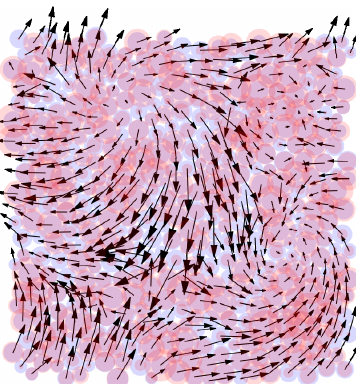
FIG. 6. Example of soft mode with ω ≈ 0 . 078 for ¯ α ¼ 1 and Δ ¼ 10 − 2 . Blue disks indicate the initial particles radii, red disks the new radii induced by motion along that mode. Arrows represent the displacements δ ⃗ r of the particles multiplied by 4 i for